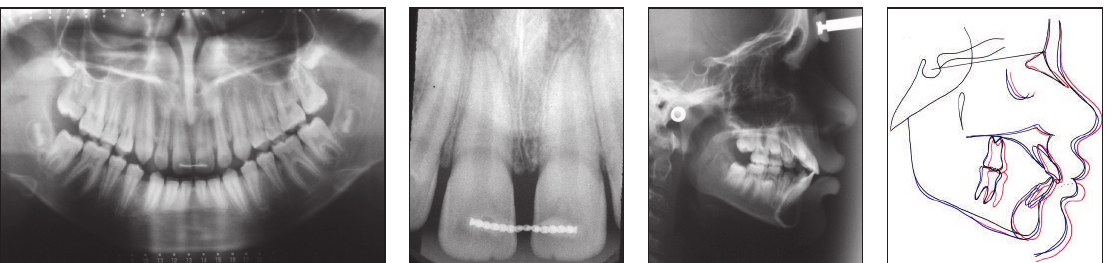
Figure 5: Posttreatment radiographs and cephalometric